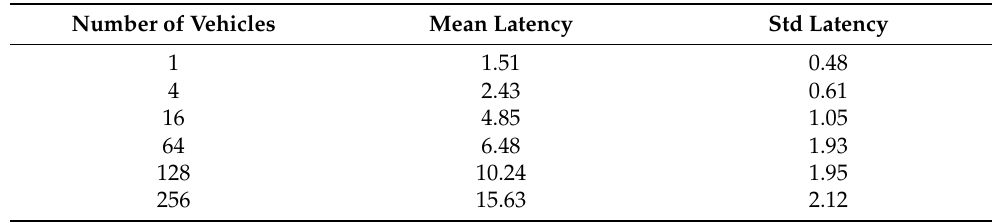
Table 3. Results of latency